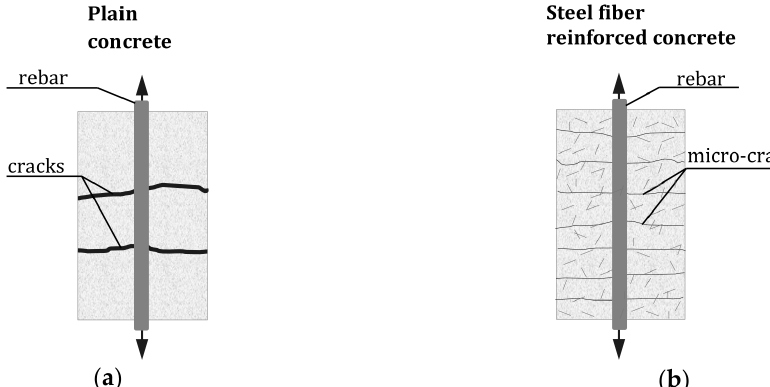
Figure 2. Size and distribution of cracks in reinforced concrete elements subjected to tension: ( a ) plain concrete; ( b ) fiber–reinforced concrete (FRC) [own study on the basis of Reference [13, p. 266, figure 9.10]].